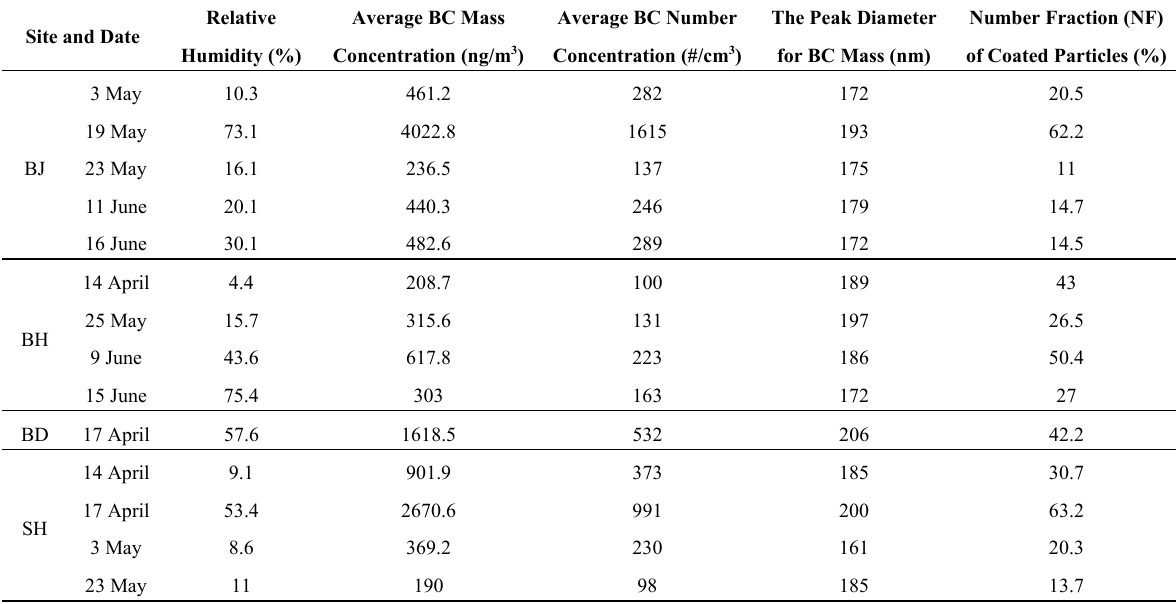
Table 2. Summary of measured results from different flight locations a .